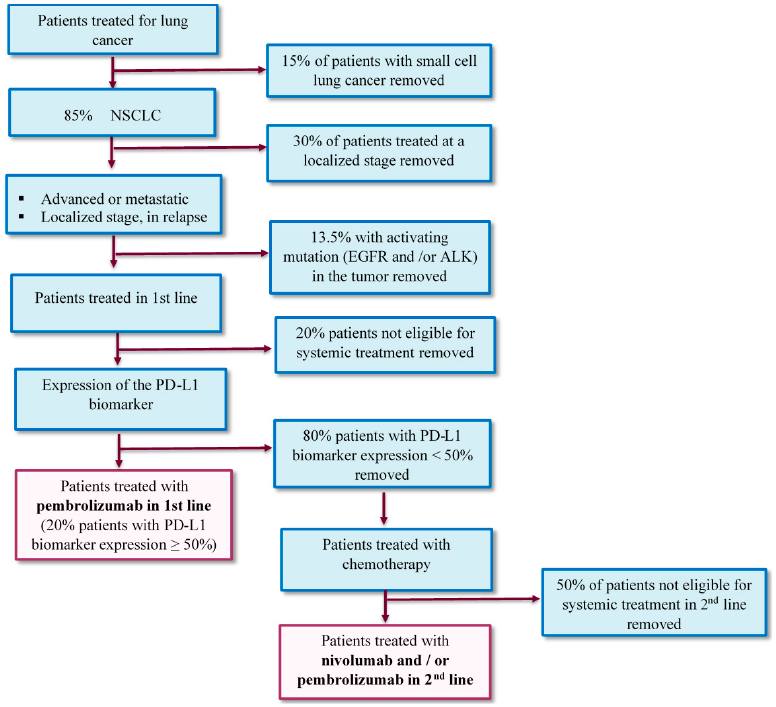
Figure 2. Target patient population in the base case analysis . ICI used are in bold .